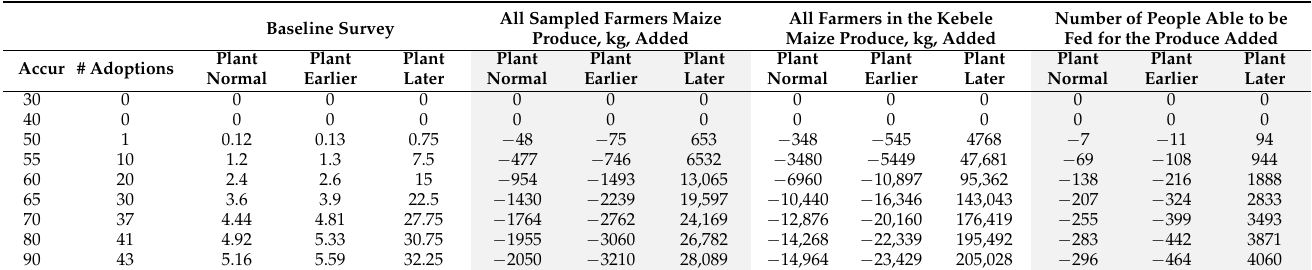
Table A10. Adoption rate of weather forecast accuracy, crop productivities of adopted numbers, and number of people able to be fed under less rain conditions. Baseline Survey